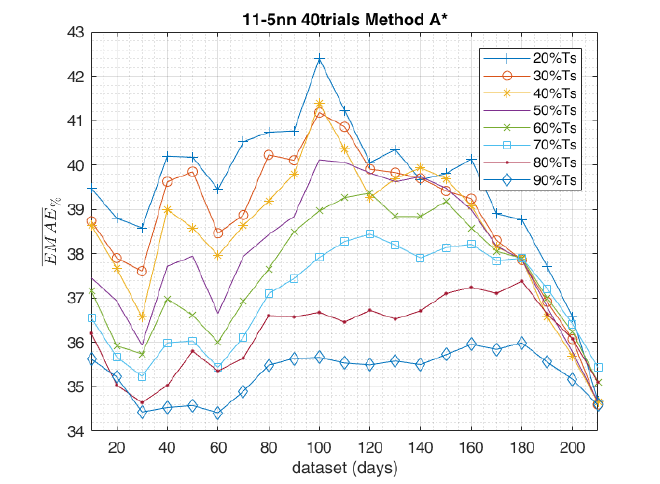
Figure 14. EMAE % as a function of the dataset